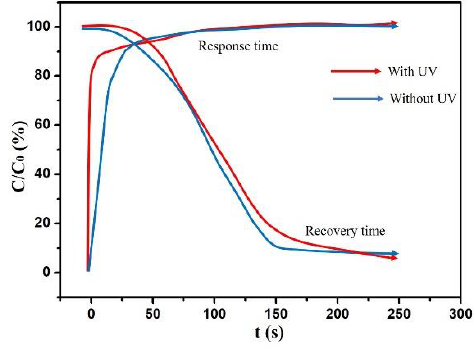
Figure 7. The response and recovery times under RH = 90%.